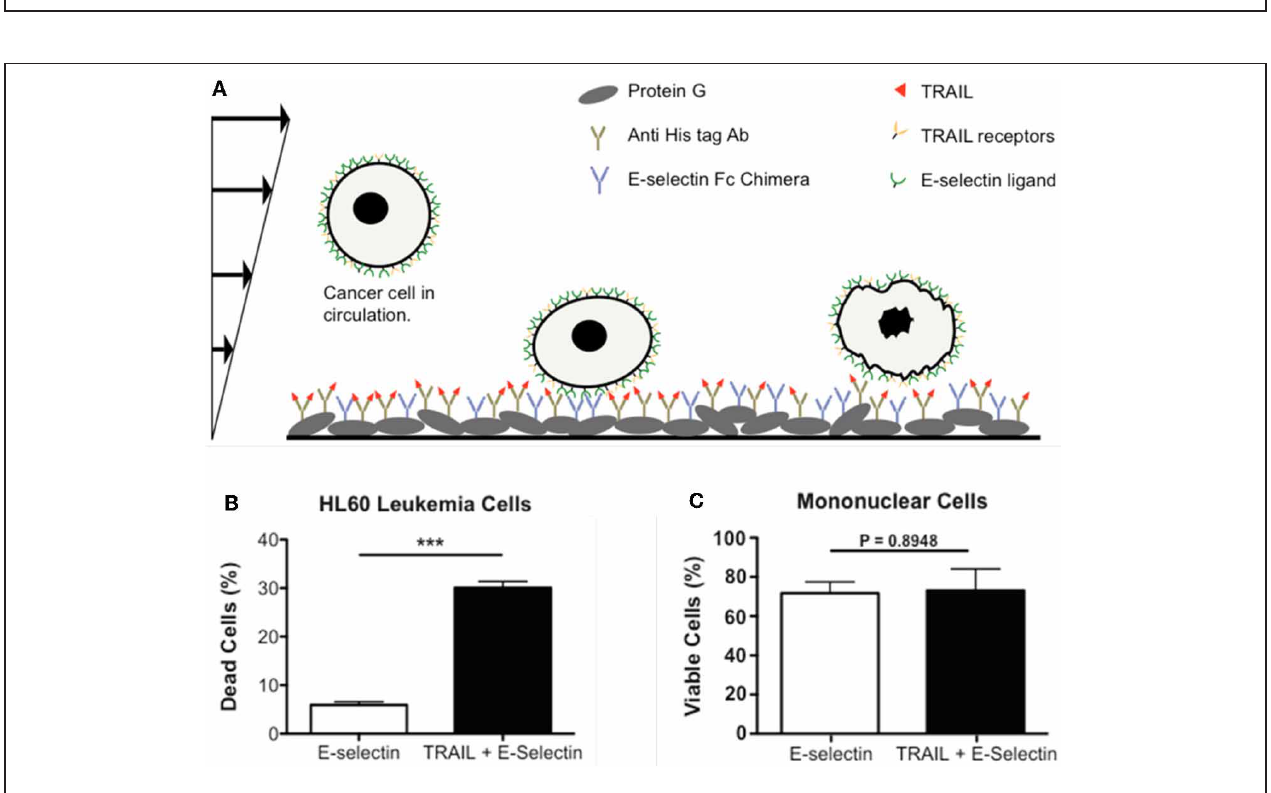
FIGURE 3 | Delivery of apoptotic signal to rolling cancer cells. (A) Schematic of a biomimetic device for inducing apoptosis in CTCs using E-selectin and TRAIL. (B) HL60 leukemic cells are eliminated by approximately 30% following perfusion through a device coated with both